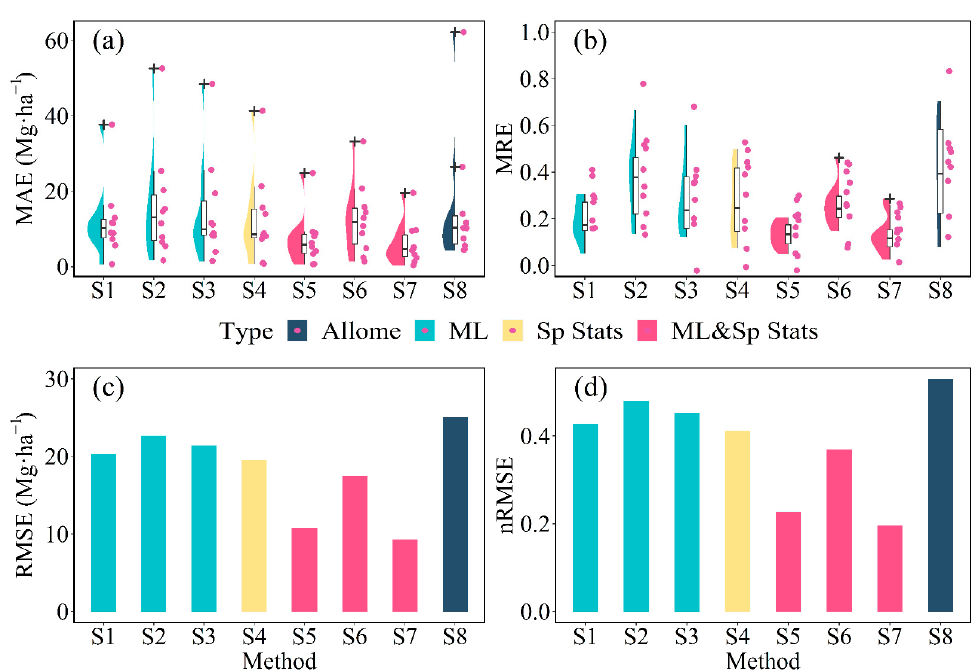
Figure 4. Prediction performance of the seven different models. ( a ) MAE and ( b ) MRE are presented as boxplots for each prediction method, with the median (black horizontal line in the box), interquartile range (25–75% in the box), range 5–95% (whiskers), and outliers (asterisks) labeled (S1 = SVM, S2 = RBF-ANN, S3 = RF, S4 = P-BSHADE, S5 = SVM & P-BSHADE, S6 = RBF-ANN & P-BSHADE, S7 = RF & P-BSHADE, S8 = allometric model, Allome = allometric model, ML = machine learning, and Sp Stats = spatial statistics). Histogram distributions of RMSE and nRMSE for each prediction method are presented in panels ( c ) and ( d ), respectively.